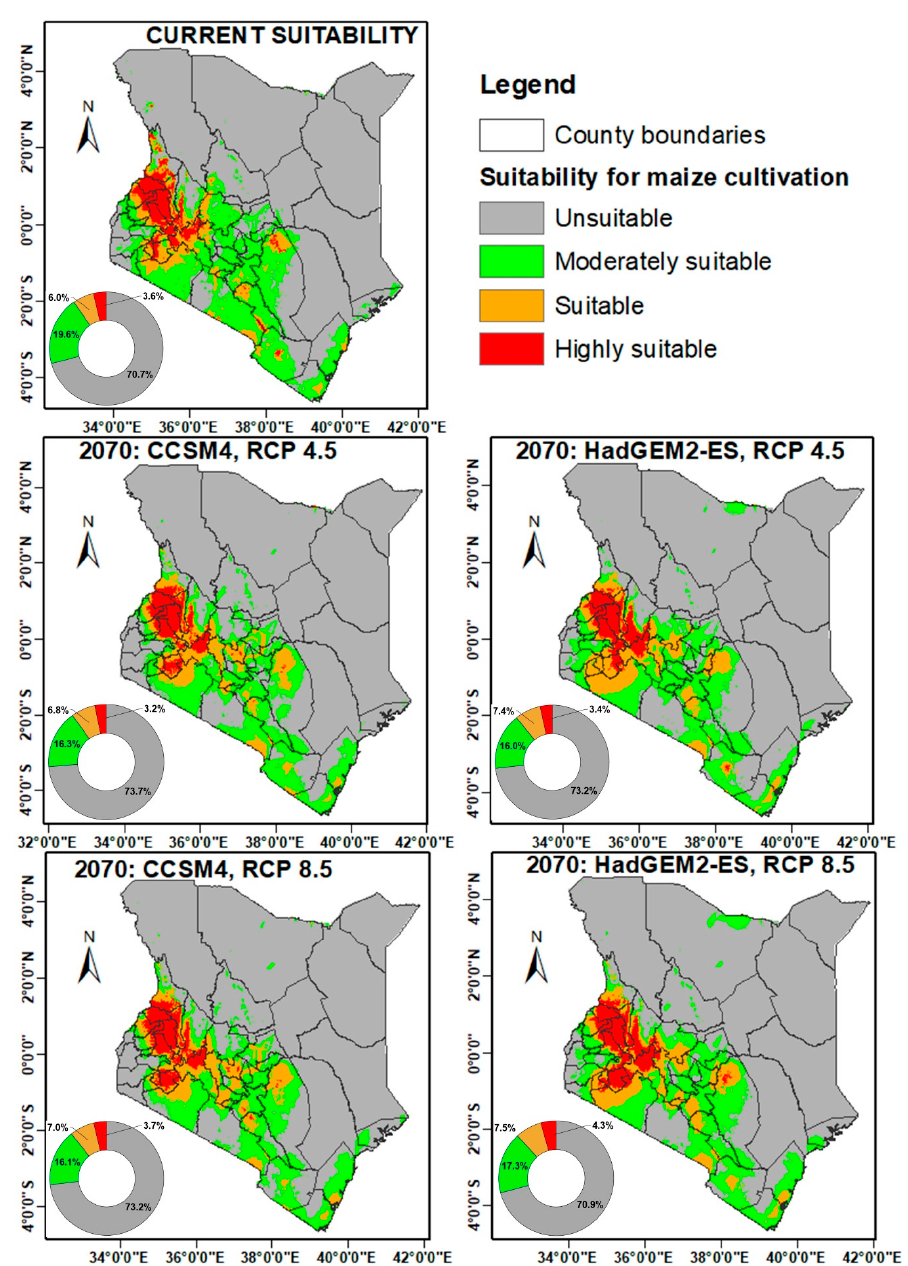
Figure 6. Potential geographic suitability for maize production under current and future climatic conditions in Kenya. The inset is a pie chart showing the potential coverage of each class of suitability.